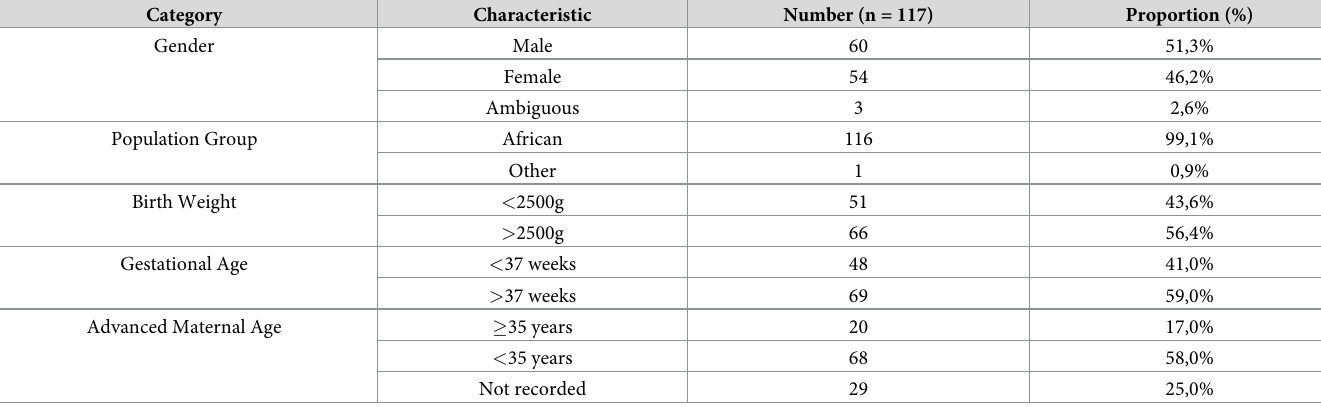
Table 1. Demographic characteristics of new-borns affected by congenital anomalies at Edendale Hospital, 2018 (study population). Category Gender